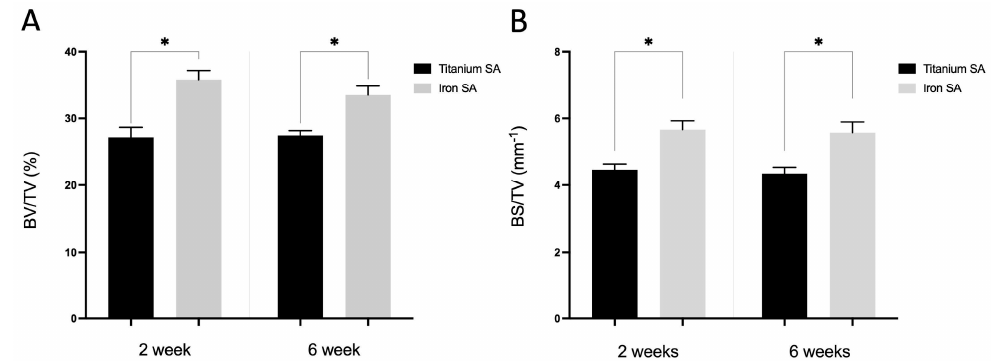
Figure 10. Micro-computed tomography (micro-CT) analysis. Quantitative evaluation of the bone volume (BV) between the bone and SAs. The tissue volume (TV, mm 3 ), BV (mm 3 ), and BS (mm 2 ) were examined in a region of interest (ROI) of 200–1000 μ m around the implant. ( A ) BV fraction (BV/TV, %) and ( B ) BS density (BS/TV, mm − 1 ) represent the BV rate and bone tissue surface rate, respectively. Mean ± SEM. * p < 0.05.